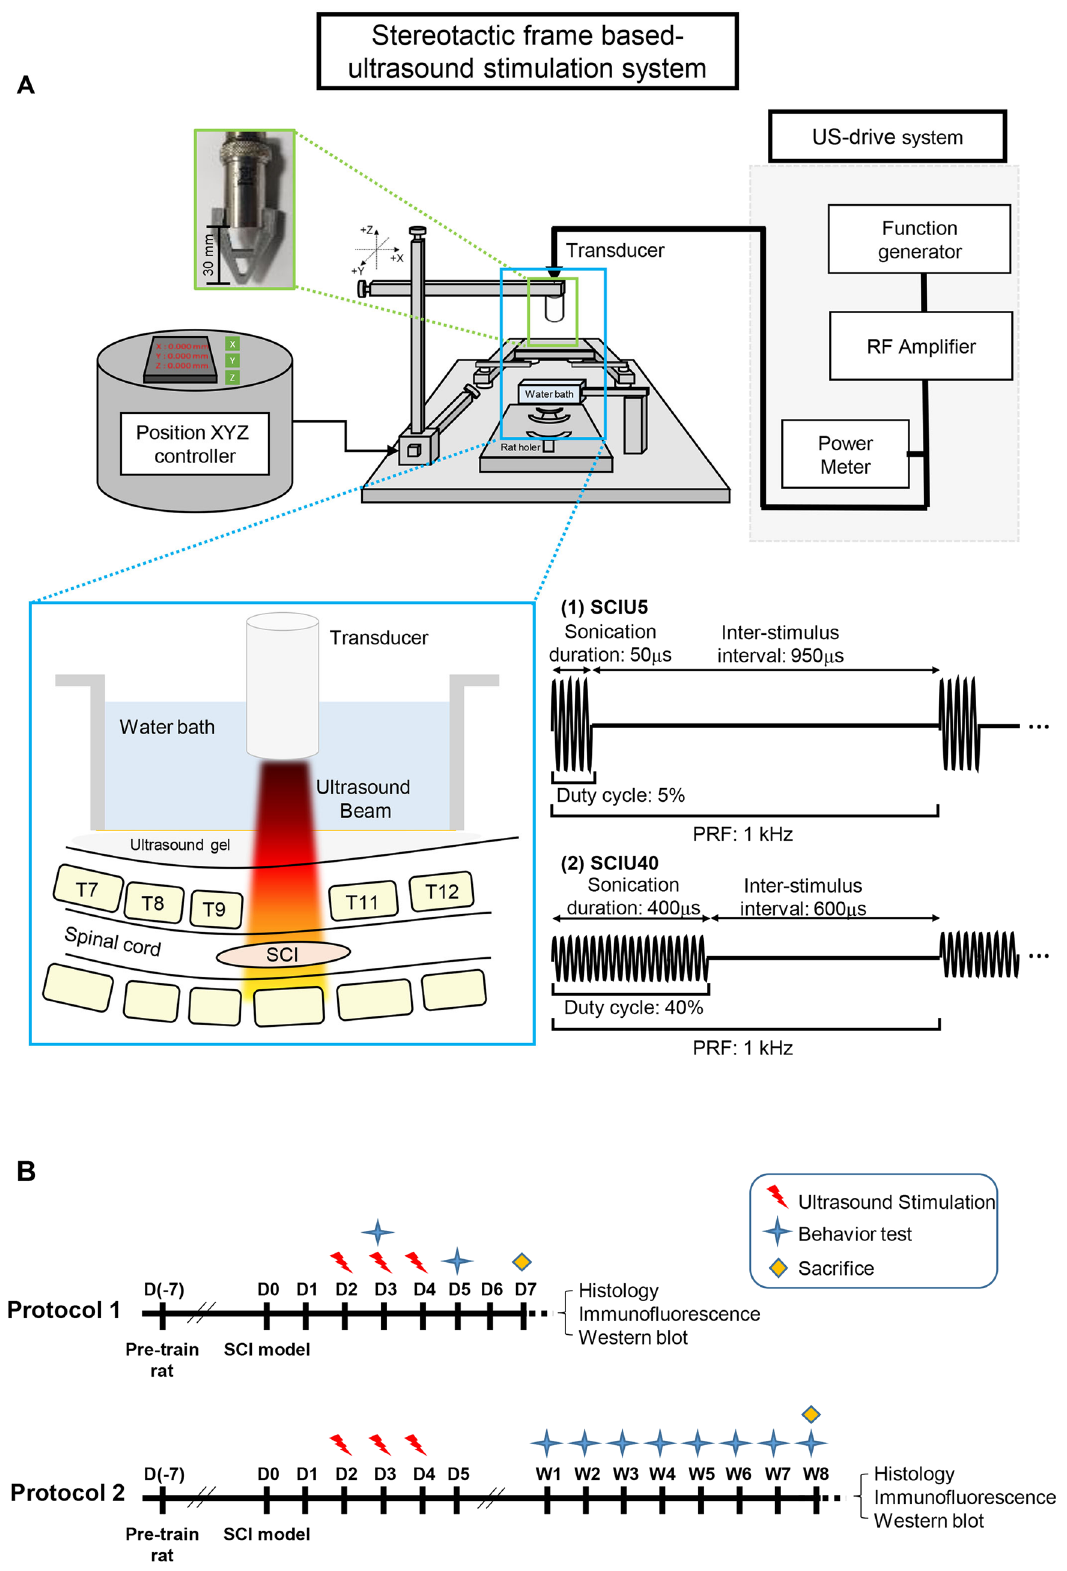
Figure 1. Experimental setup of the customized US stimulation system. ( A ) US stimulation with two different parameters, SCIU5 and SCIU40, was applied to spinal cord injury model rats. Schematic illustration of the customized US stimulation systems. ( B ) Experimental design for the evaluation of the effect of US stimulation on a rat model of SCI. Models were established on day 0 and subjected to US stimulation three times (2, 3, and 4 days following traumatic cord injury. Protocol 1; acute SCI phase study (days 1–7). Protocol 2; chronic SCI phase study (8